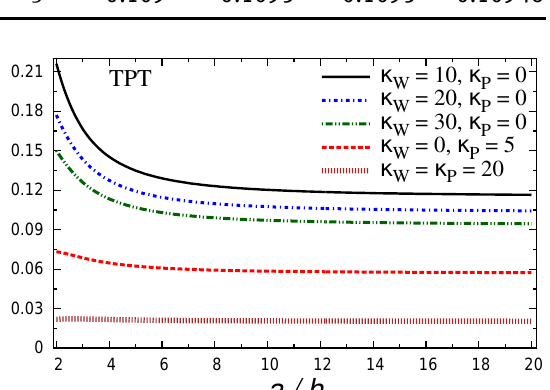
Figure 3: Effects of the foundation parameters on the deflection w through-the-thickness of the EG thick square plate ( a = 4 h , k = 1.5) .